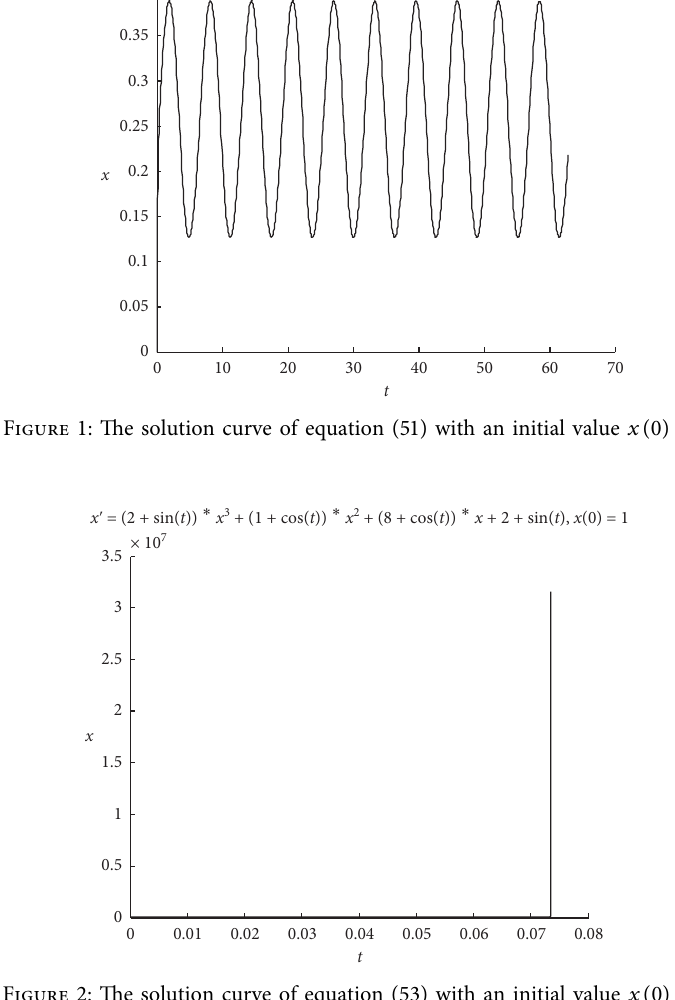
Figure 2: The solution curve of equation (53) with an initial value x ( 0 ) �